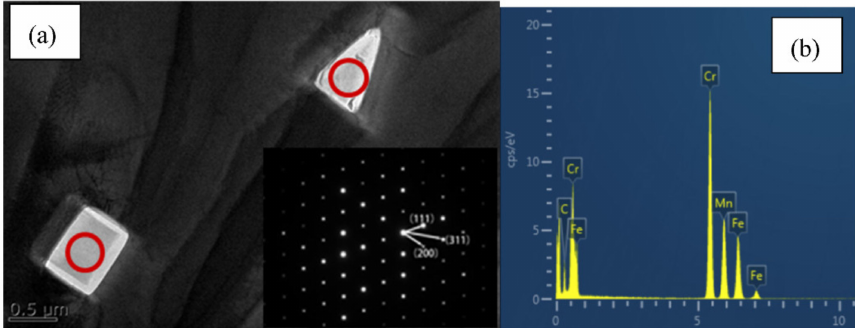
Figure 6. M 23 C 6 precipitates enriched with Mn and Fe in 18CrN sample: ( a ) TEM and diffraction pattern; and ( b ) EDS